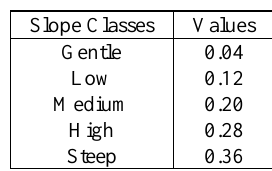
Table 13. The weighted values of slopes